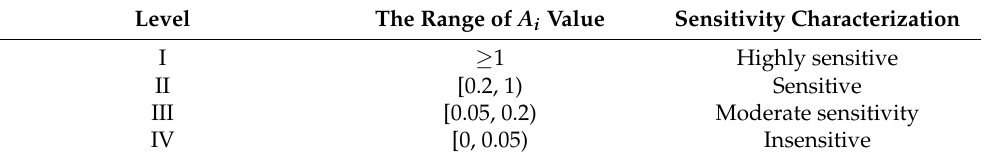
Table 3. Rating of parameter sensitivity.